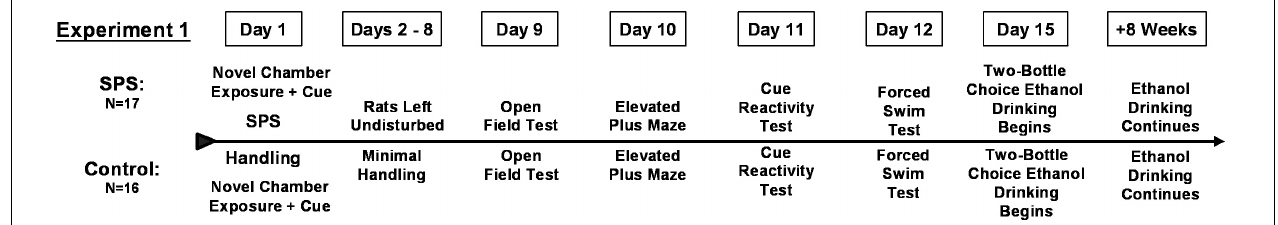
FIGURE 1 | Timeline for Experiment